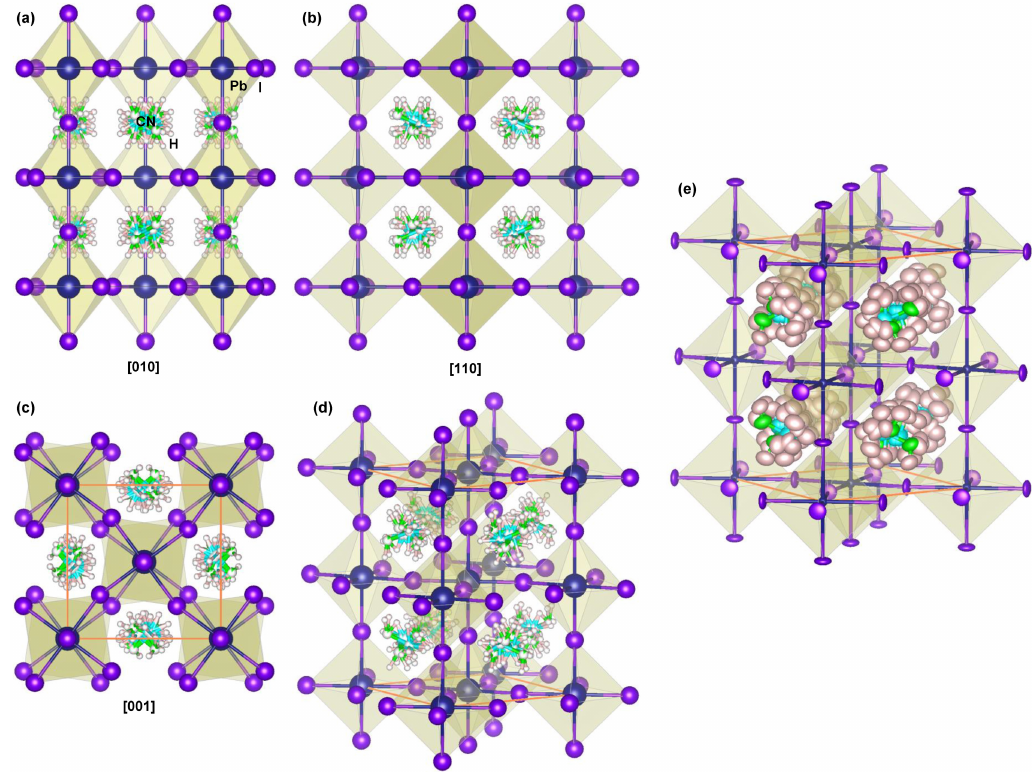
Figure 8: Structural models of tetragonal CH 3 NH 3 PbI 3 observed along (a) [010], (b) [110], and (c) [001] directions. (d) Perspective view of the tetragonal structure and (e) atomic displacement parameter ellipsoids shown at 50% probability of